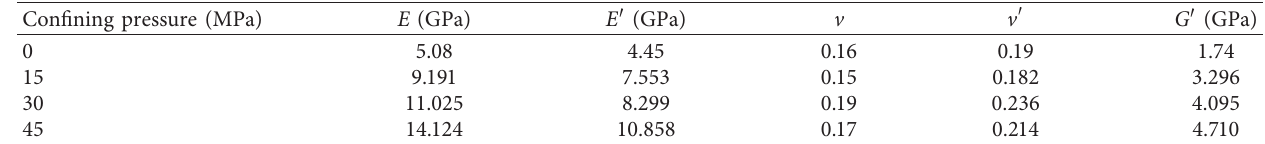
Figure 9: Fitting curves of the reciprocal of elastic modulus ( 1 / E Table 6: The five independent parameters of the tight sandstone samples.